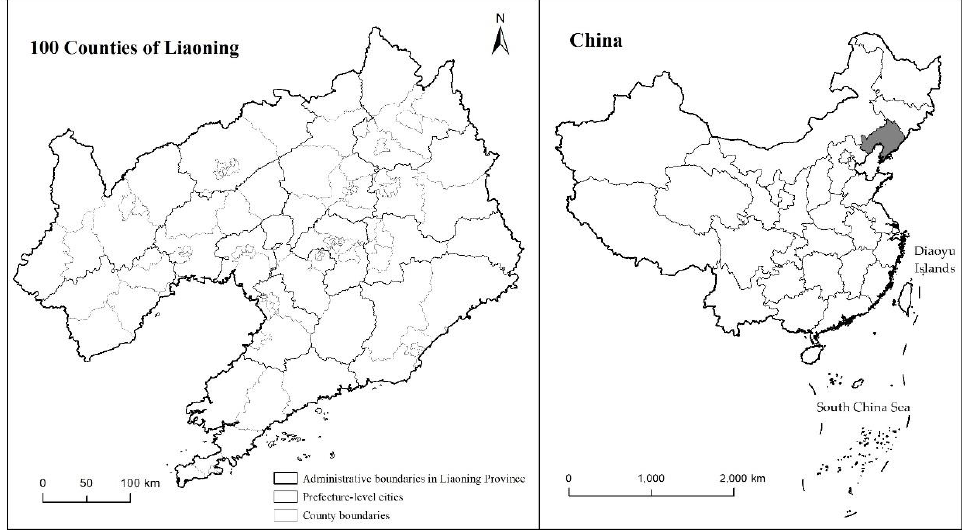
Figure 1. Location of the study area.